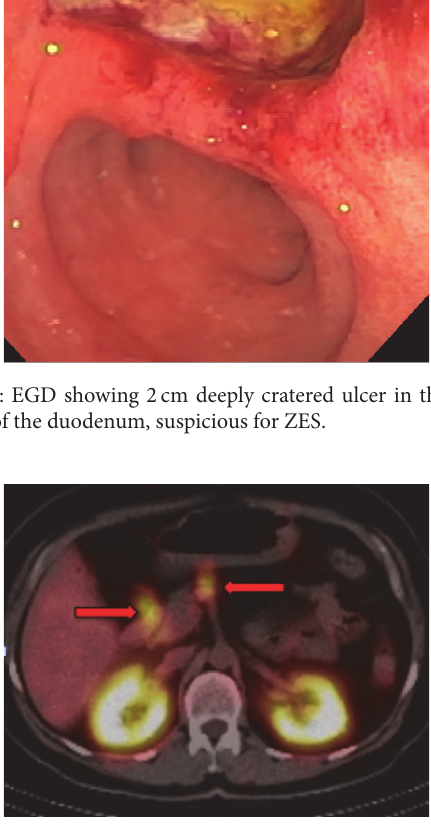
Figure 2: Somatostatin receptor scintigraphy (SRS) showing two small foci of moderately intense abnormal radiotracer uptake within the gastrinoma